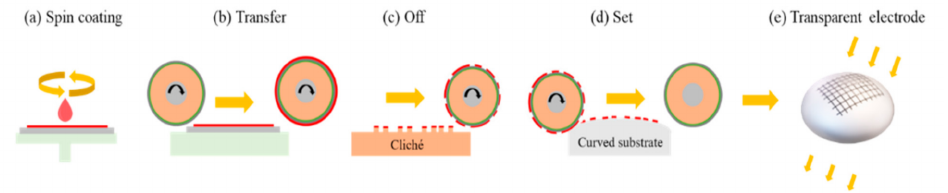
Figure 1. Double-layer blanket (DLB) reverse offset printing process. ( a ) Spin coating ( b ) Ink transfer from bottom blanket to roll blanket ( c ) Off from roll blanket to Clich é ( d ) Pattern set ( e ) Transparent electrode.